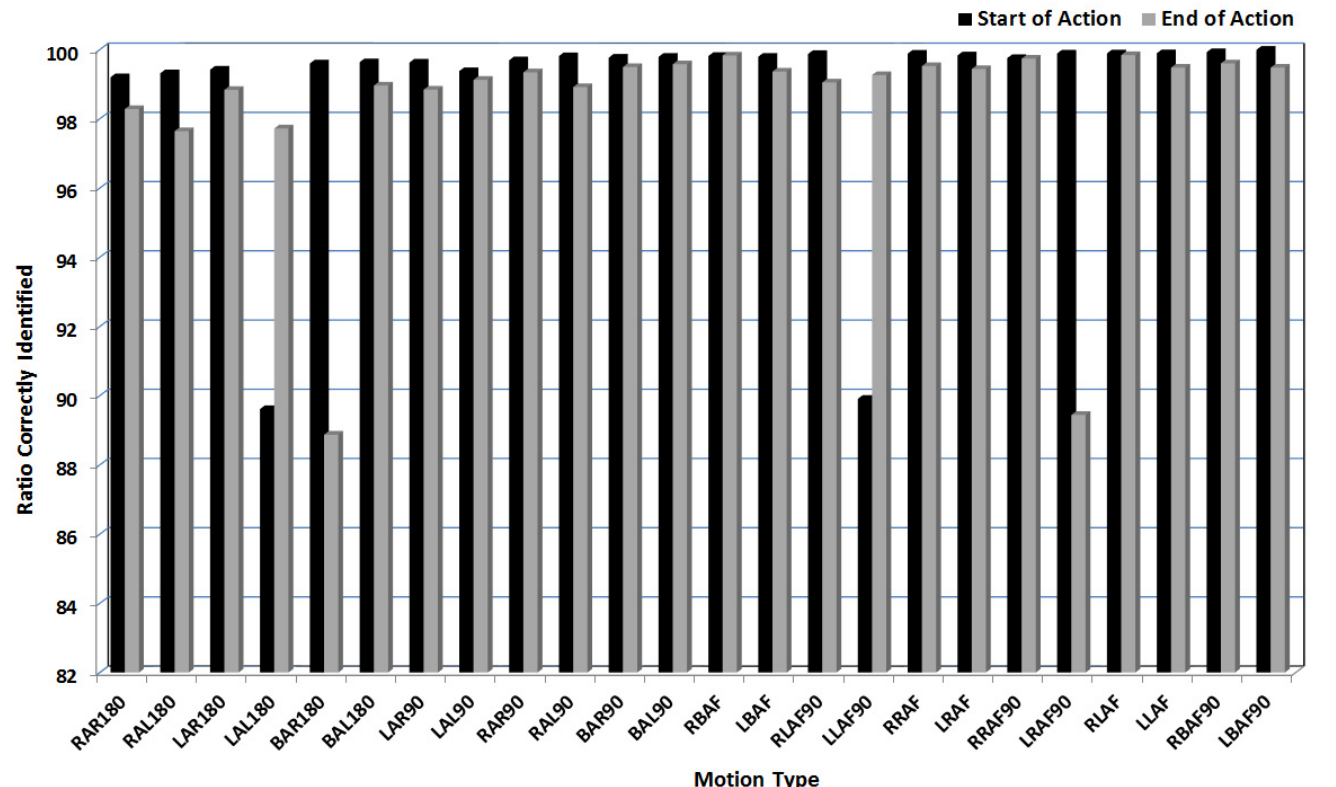
Fig 12. Ratio of average accuracy of segmentation results calculated between joint based segmentation and Incremental Kernel SFA segmentation.